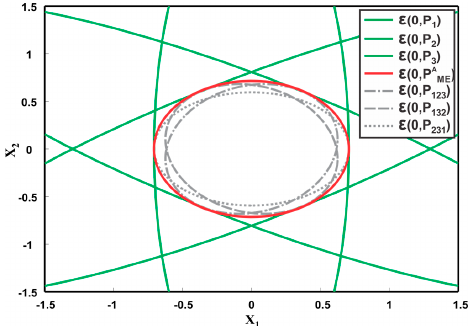
Figure 13. Illustration of three ellipsoids ε(0,P (cid:2869) ),ε(0,P (cid:2870) ),ε(0,P (cid:2871) ) and their fusion result provided by ME methods. The figure also shows the actual fused result ε(0,(cid:1842) (cid:3014)(cid:3006)(cid:3002) ) for ME methods.